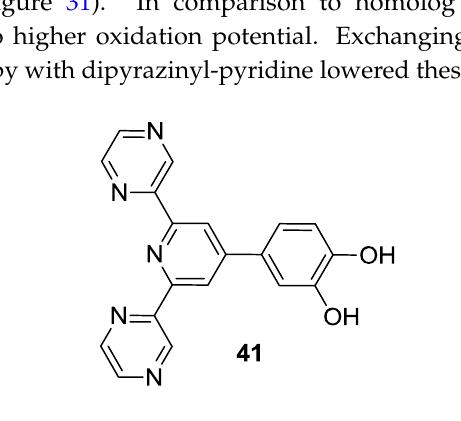
Figure 33. Ru(II) complexes proposed by Park et al. [142]. X-ray crystal structure of 43b shows a typical geometry with both ligands coordinated in a meridional fashion; bond distances between Ru and the coordinated N or C are similar and the carboxyl function is deprotonated (Figure 34). Overall efficiencies were far from N719 tested in the same conditions, a result that was mainly attributed to low charge injection. Figure 34. ORTEP drawing of complex 43b [142] (Reprinted with permission from Park, H.-J.; Kim, K. H.; Choi, S. Y.; Kim, H.-M.; Lee, W. I.; Kang, Y. K.; Chung, Y. K. Unsymmetric Ru(II) Complexes